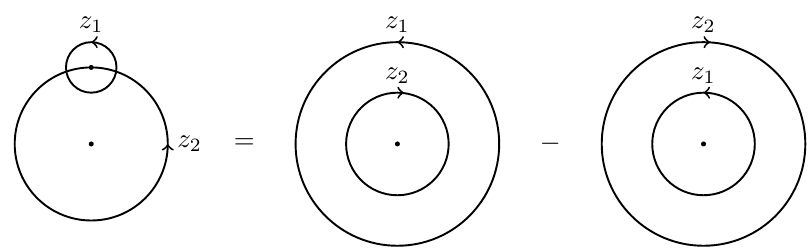
Figure 6 . Equivalence of contours used to test for